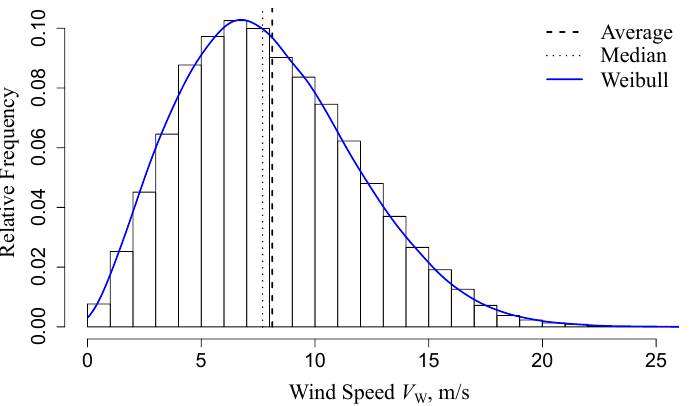
Figure 4. Measured wind speed V W at a unmanned lightvessel named “Deutsche Bucht”, located approximately 35km north from the island Langeoog (Database from